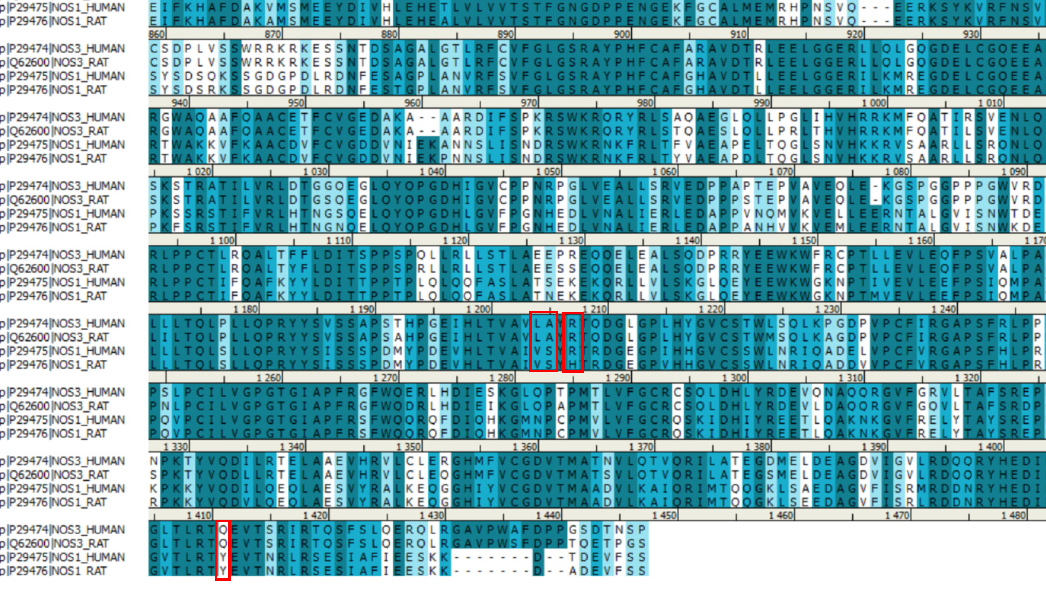
Figure A5. ( A ) Gating of NT 3_3, NT3_5 and NT3_7 binding to eNOS exemplified by the distance between A958 and T1016. One representative run of 20 ns out of three. Gating elements of NT’s binding to eNOS. ( B ) shows a simplified view of the NT3_7, 5, and 3 within their binding site. This view has a 90° rotation as compared to Figure 4 where the “gating” elements are shown in yellow.